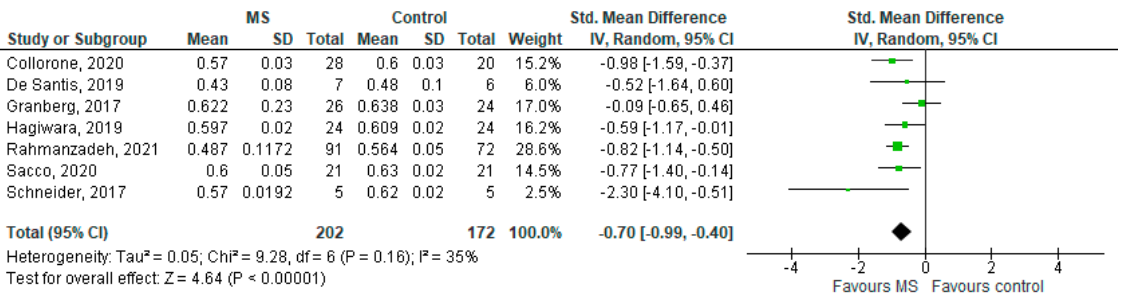
NAWM = normal-appearing white matter; vs. = versus; and I2 = Heterogeneity Index.